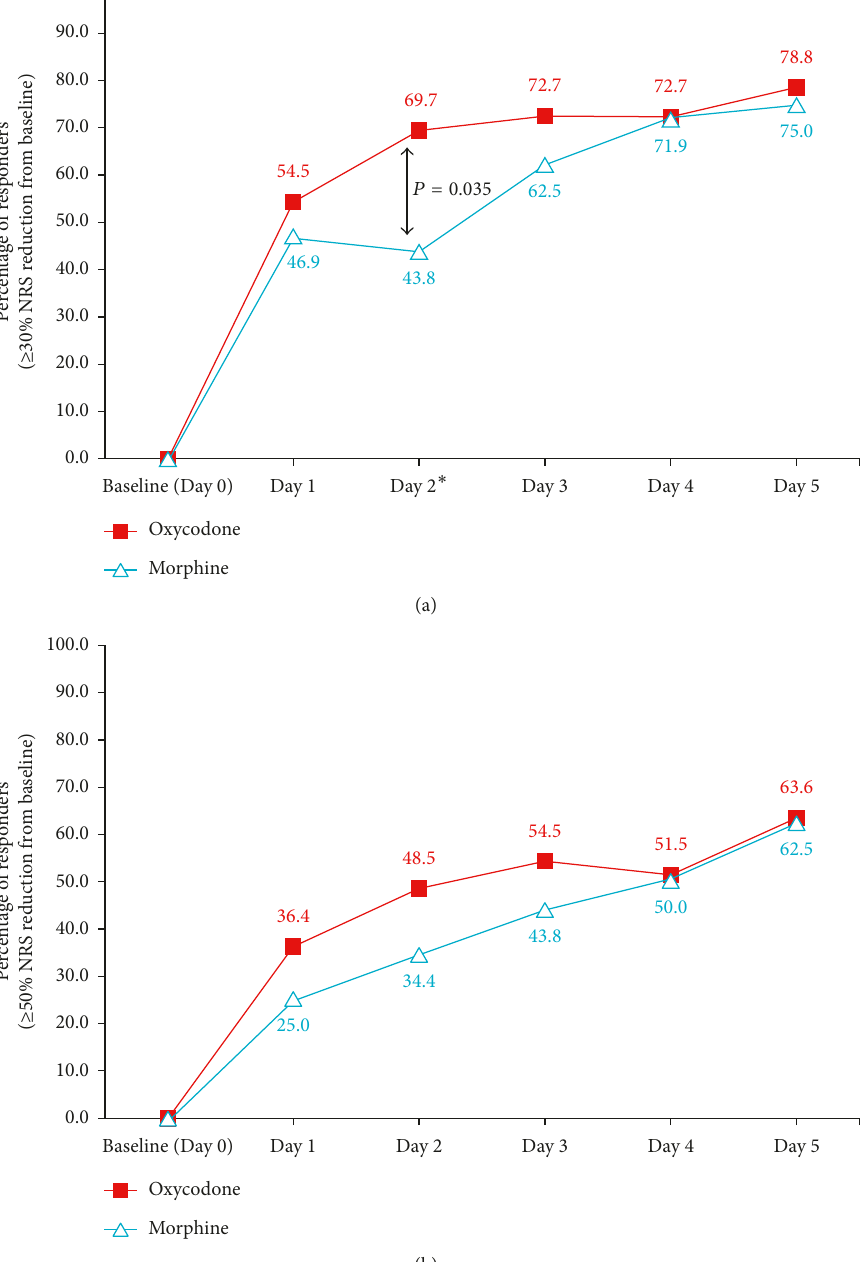
(b) 30% and (B) 50% NRS reduction from baseline. ≥ ≥